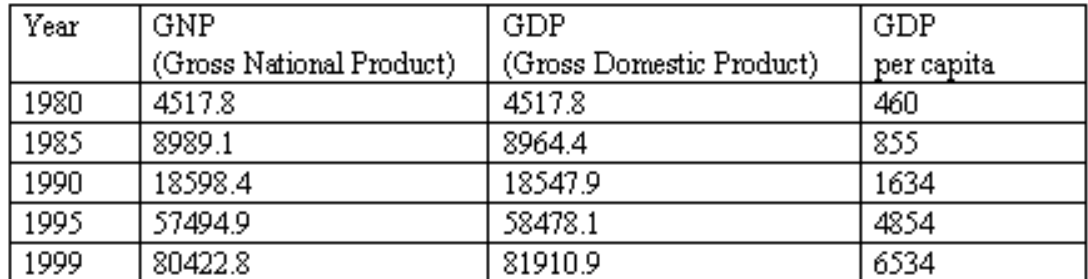
GNP and GDP Increase in China, 1980 - 1999 (Unit: RMB100